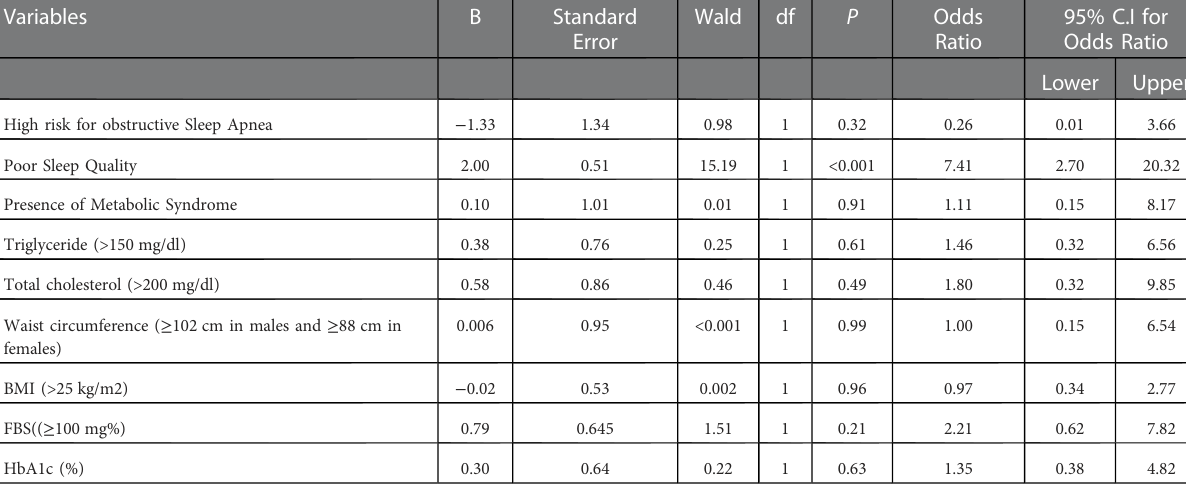
TABLE 2 Multivariate logistic regression model showing risk factors for increased carotid intima media thickness. Variables B Standard